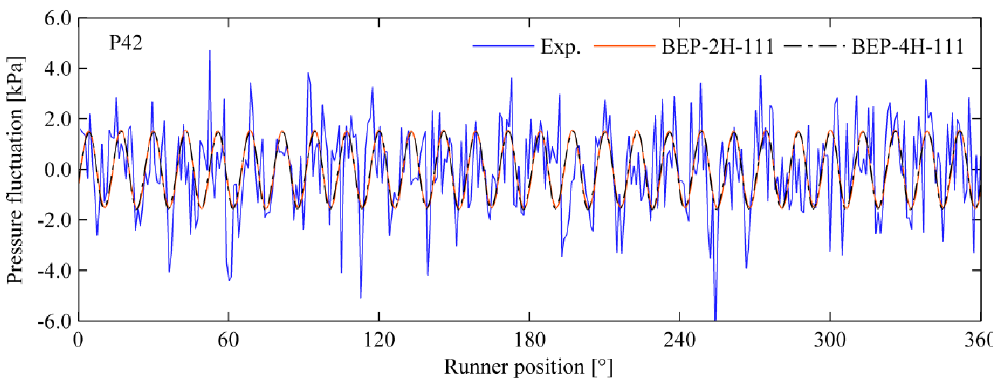
Figure 16. Instantaneous pressure variation on the blade pressure side at the BEP [16].